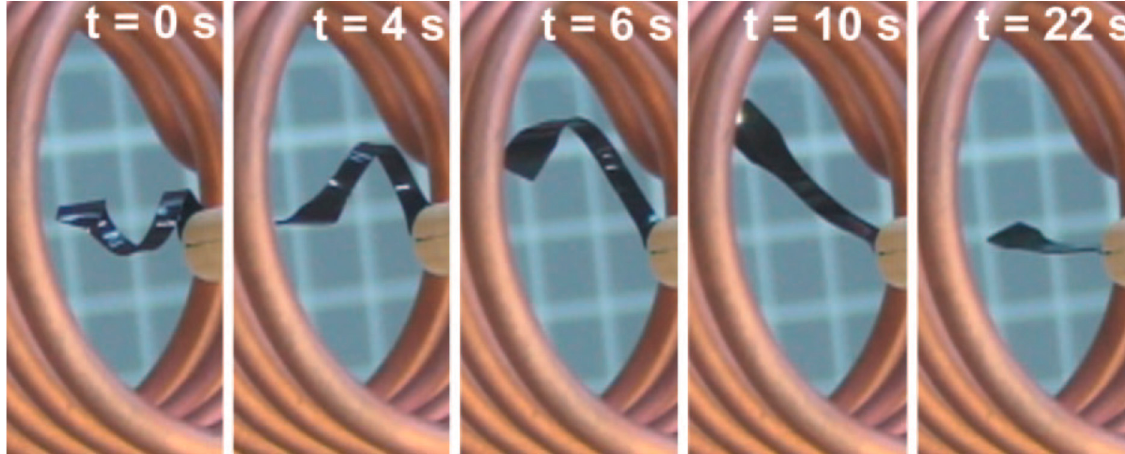
Figure 2. Shape memory effect through induction heating [19] .